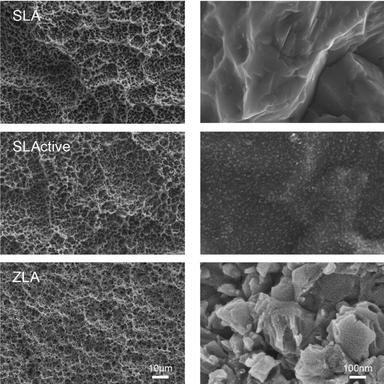
Surface characterization of the different implant materials. Scanning electron microscopy (SEM) images of SLA, SLActive, and ZLA at 2 different magnifications. Nanostructures were only present on SLActive and ZLA surfaces.